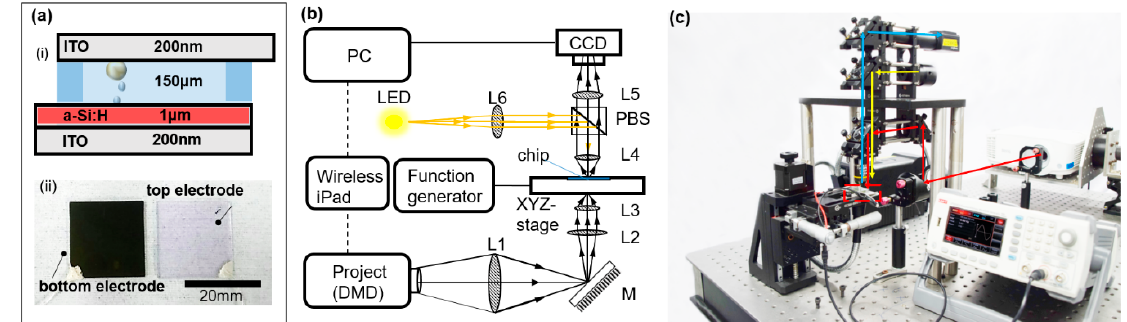
Figure 3. Schematic diagram of OET system installed on a microfluidic chip. ( a ) Structure of fabricated a-Si:H microfluidic chip. ( b ) Image projection path through lenses L1, L2, and L3 and reflection from mirror M. L4, PBS, L5, and CCD comprise the observation path; LED, L6, PBS, and L4 comprise the illumination path. ( c ) Picture of the OET system.